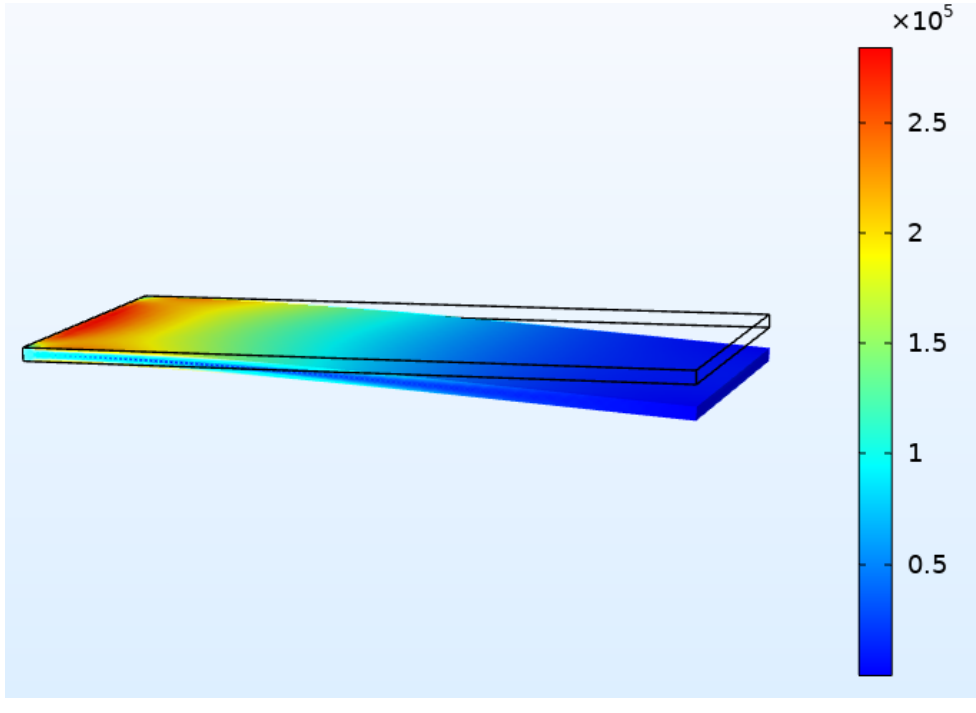
Figure 13. PVDF film stress using the